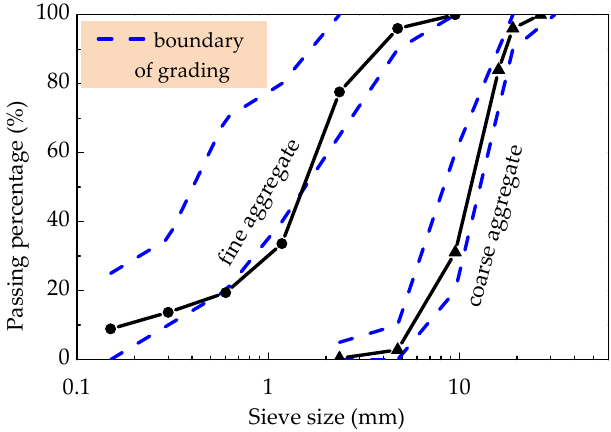
Figure 2. Grading curves of coarse expanded-shale and ceramsite sand.